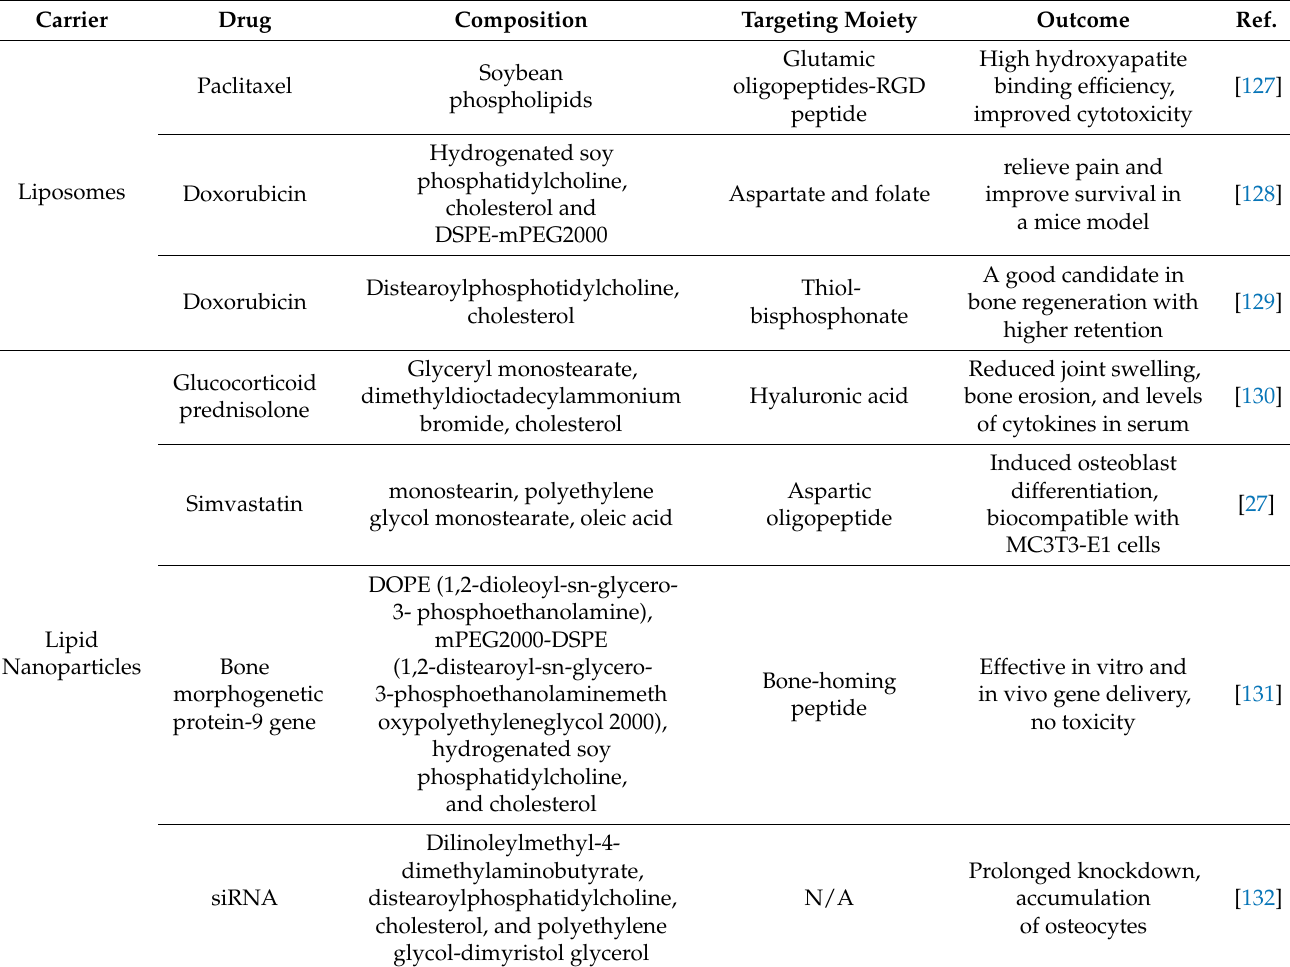
Table 2. Different lipid compositions and targeting moieties exploited in bone